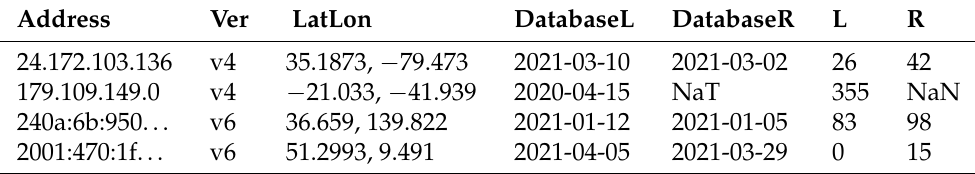
Table A4. Format of file 2020–2021_lifetime.csv with processed survival data and sample.